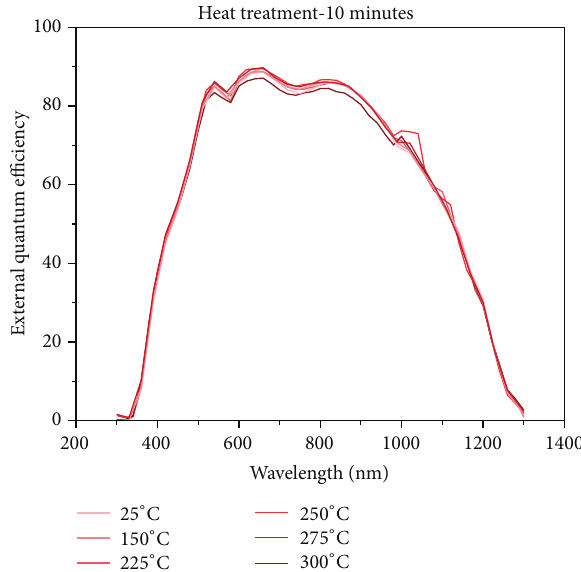
Figure 5: EQE of samples D heated for 600 seconds. The darker the color the more the heat treatment.